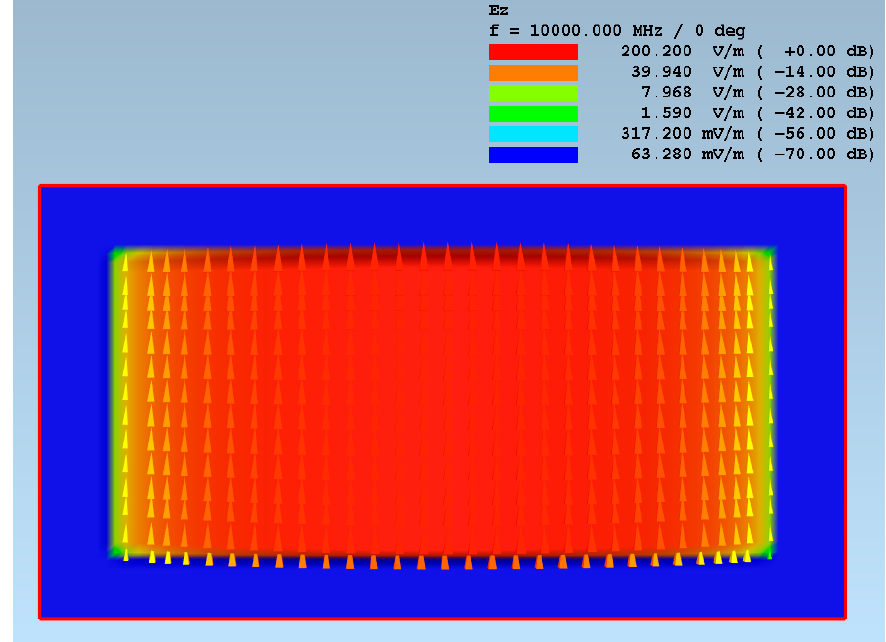
Figure 4. Simulated electric fields in the X-band rectangular waveguide. 3.3. Open Resonator: Model 600T from Damaskos, Inc.